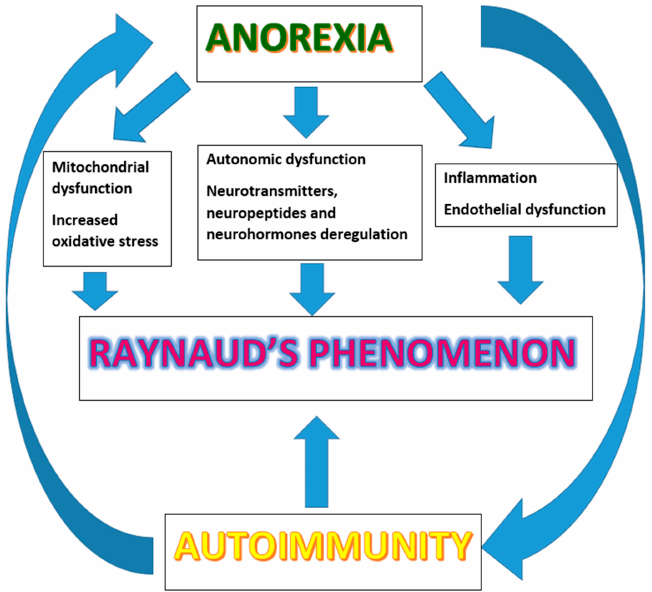
Figure 2. The complex relationship between anorexia nervosa, peripheral vascular abnormalities, and autoimmunity. Psycho-neuro-endocrine-immunology offers a new unifying view of these disorders. Immune, neuroendocrine, and autonomic nervous system dysregulation are described in AN. The presence of Raynaud's phenomenon as in autoimmune disorders raises several questions. Several mechanisms, as shown, are at the basis of the peripheral vascular abnormalities. There is a bidirectional relationship between autoimmunity and anorexia nervosa: autoimmune diseases and eating disorders give each other a mutual increased risk [42,43].